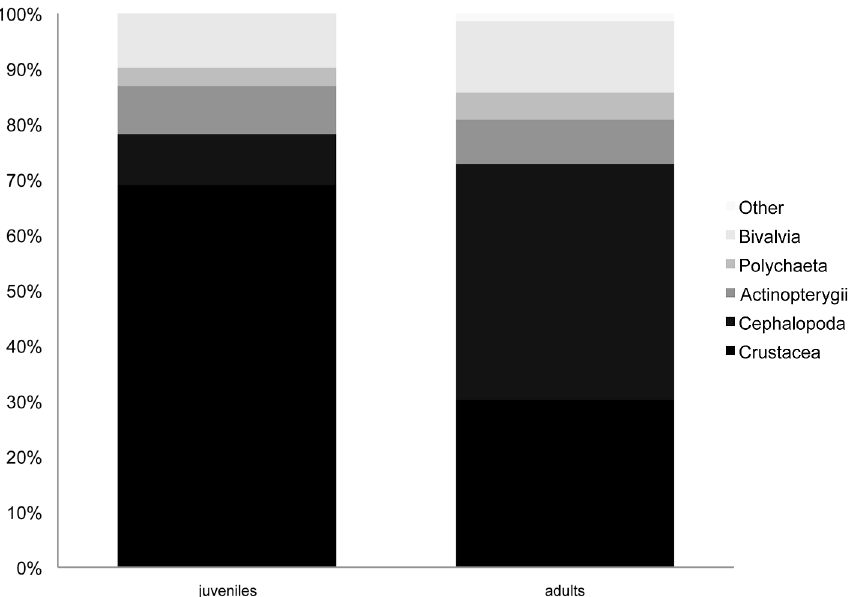
Fig. 2. Ontogenetic differences in the diet of Mustelus punctulatus, expressed as %IRI, in diet of juvenile and adult specimens